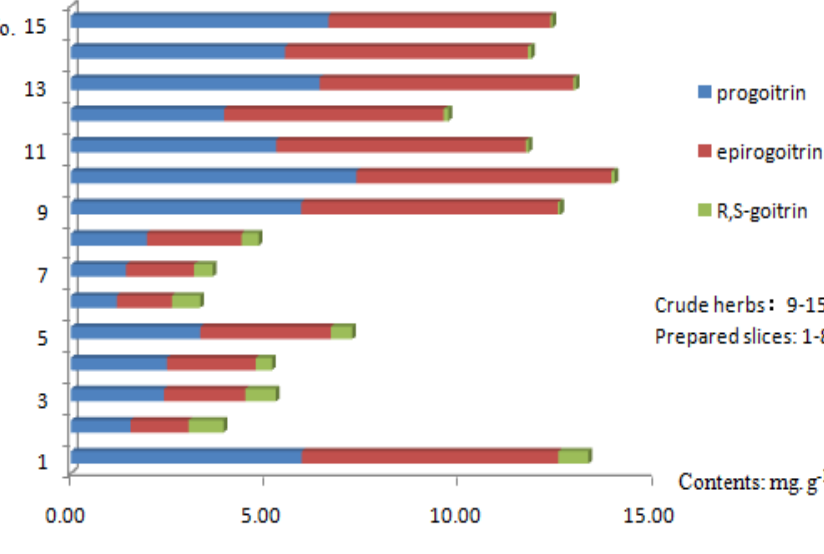
Figure 2. Bar graph of the contents of progoitrin, epiprogoitrin, and R , S -gotrin in 15 sample